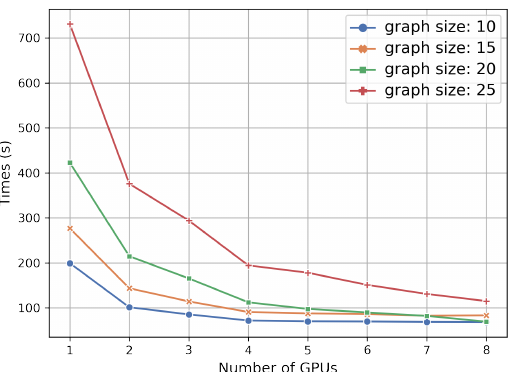
Figure 7. Test speed of pair-wise matching on GPUs. Each dataset contains 500 molecular